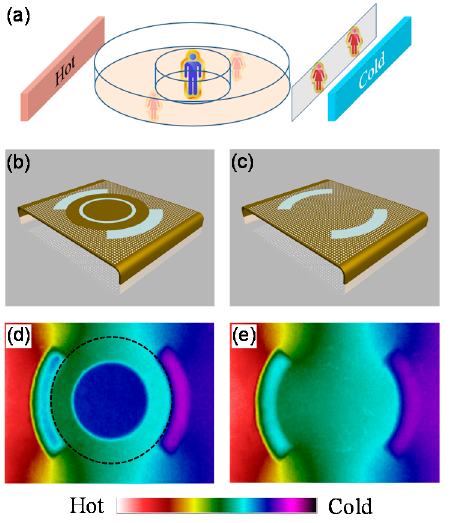
Figure 5. Thermal camouflage [57]. ( a ) Scheme of thermal camouflage; ( b , c ) schematic illustrations of the fabricated thermal camouflage and the equivalent object, respectively; ( d , e ) measured temperature distributions of ( b , c ), respectively.